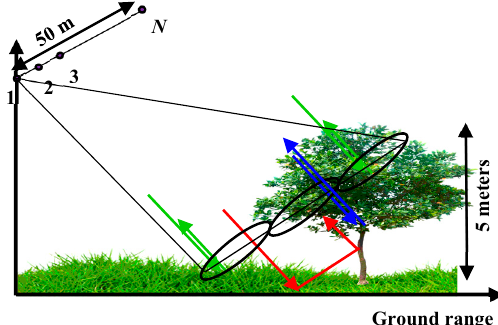
Figure 1. Simulated multi-baseline SAR geometry and the polarimetric backscatterings from forest. Red, green and blue indicate the double-bounce, volumetric and surface scattering mechanisms, respectively.